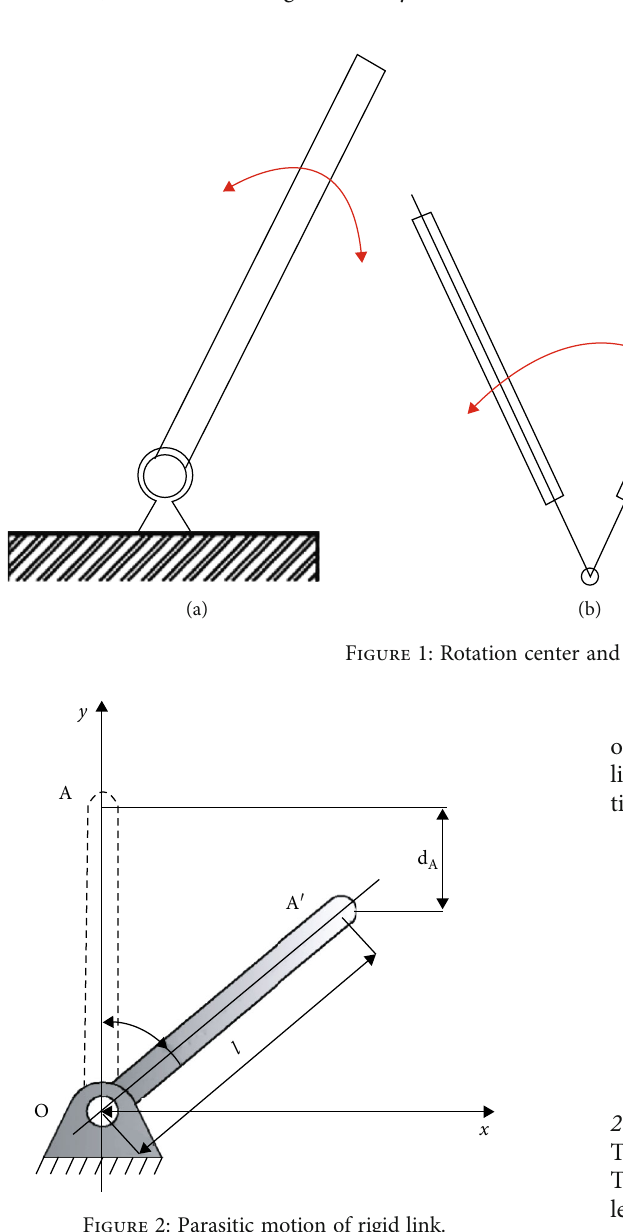
Figure 2: Parasitic motion of rigid